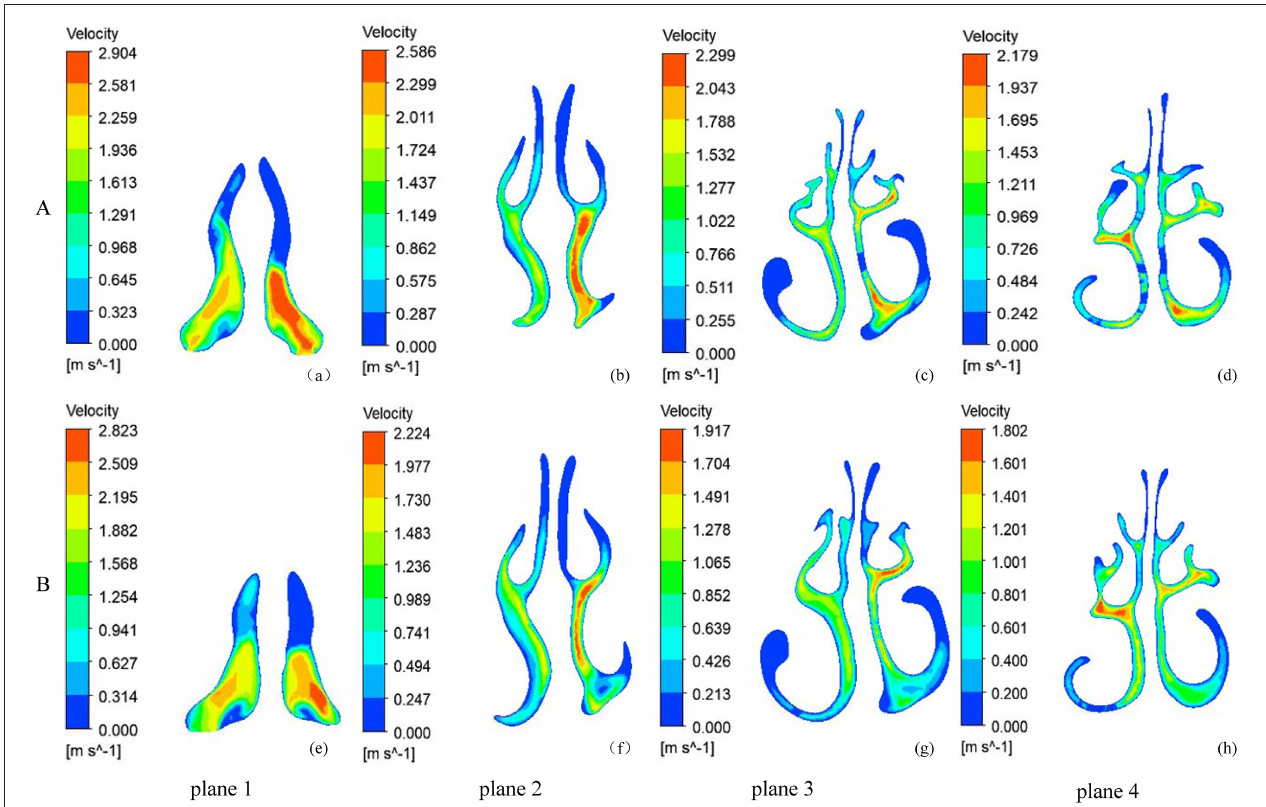
FIGURE 3 | The velocity magnitude contours at five coronal sections of a typical subject with nasal septal deviation. (A) before RME, (B) after